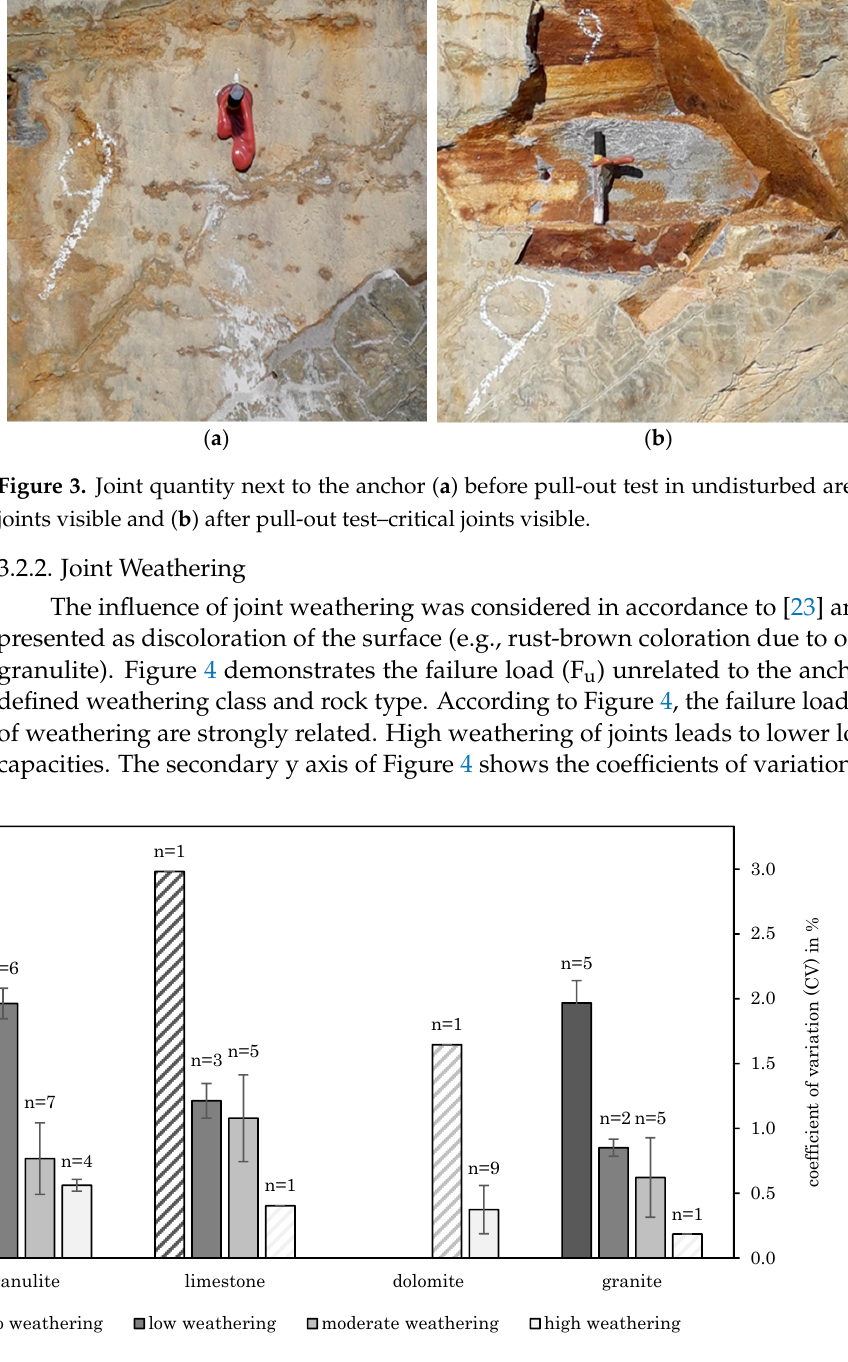
Figure 4. Failure load and CV as function of weathering class and rock type–weathering class determined after failure occurred (if n = 1 no CV is given and the beams are hatched as the data can contain an outlier).